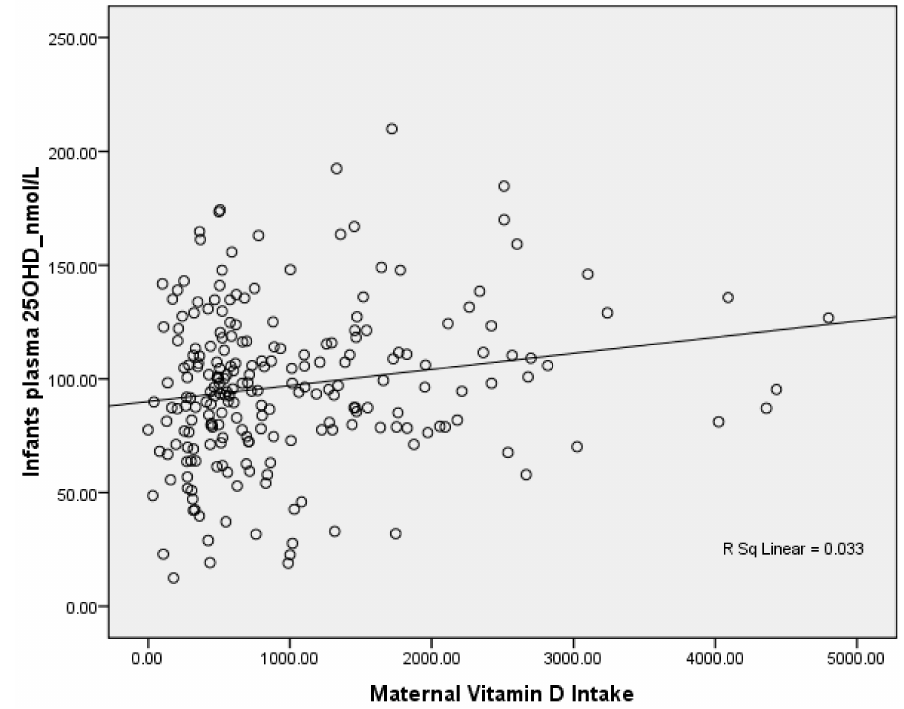
Figure 1. Correlation between infants’ plasma 25(OH)D and maternal vitamin D intake at 3 months